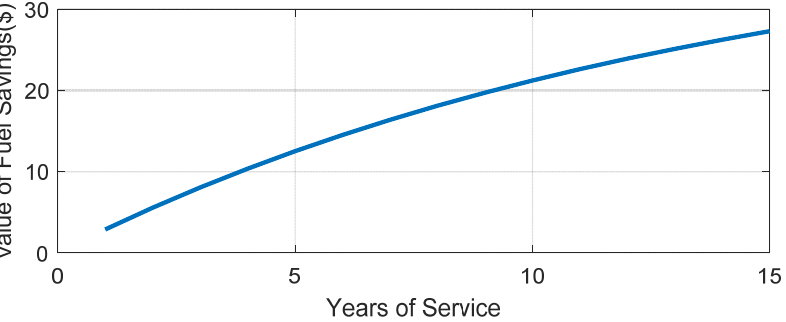
Figure 9. Present value of fuel savings over the service period of the vehicle.